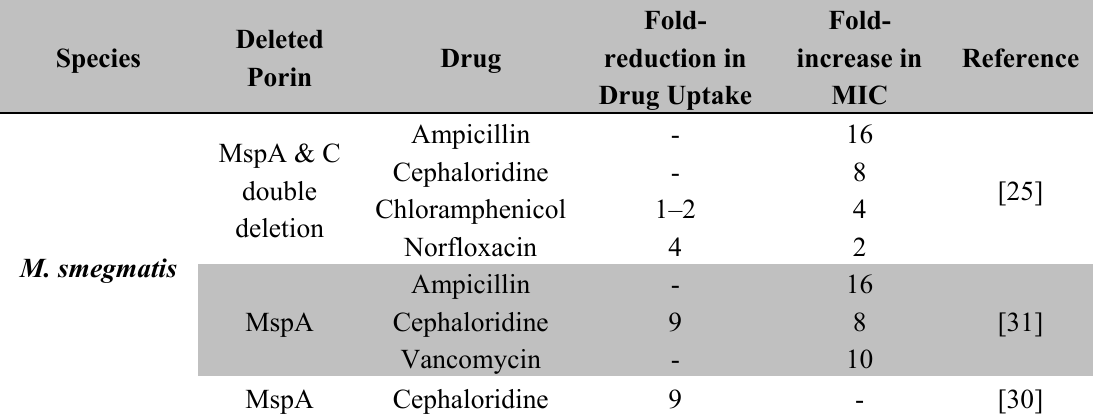
Table 1. Specific drug transport activities of mycobacterial porins of the Msp class in M. smegmatis . In all instances, porin-deletion mutants were used to determine drug transport specificity; dependence of individual drugs on porin transport is exemplified by the extent of reduction in drug uptake and increase in